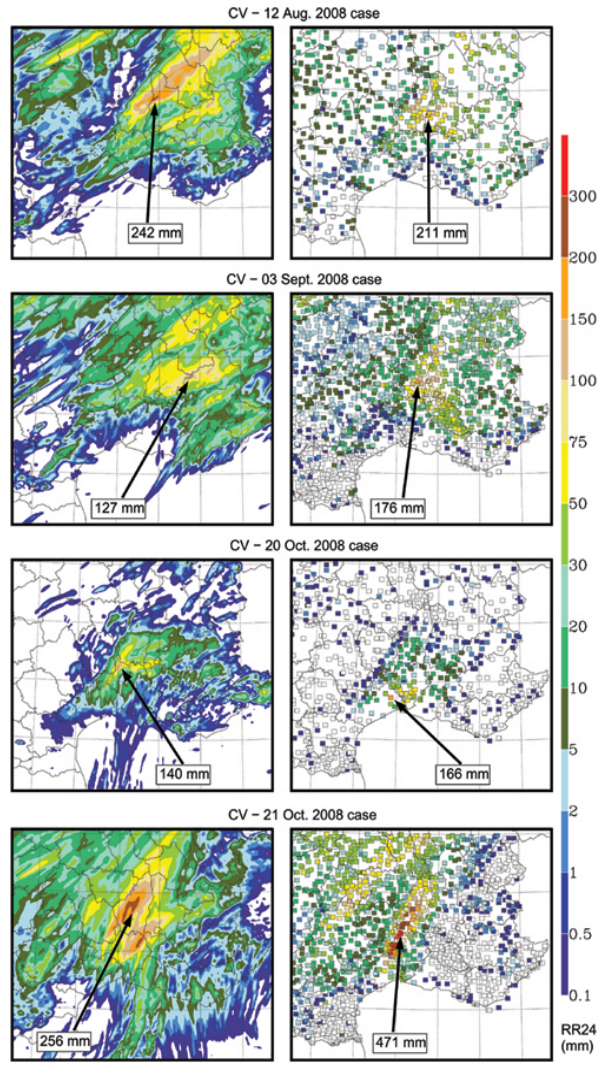
Fig. 3. 24-h accumulated precipitation (rr24 in mm) from the HRA2.5 simulations (left panels) and the M´et´eo-France rain-gauge network (right panels) at 00:00UTC, 13 August 2008 for the 12 August 2008 case (top), at 06:00UTC, 4 September 2008 for the 3 September 2008 case (middle top), at 00:00UTC, 21 October 2008 for the 20 October 2008 case (middle bottom) and at 06:00UTC, 22 October 2008 for the 21 October 2008 case (bottom). The maximum of precipitation is indicated on each panel.